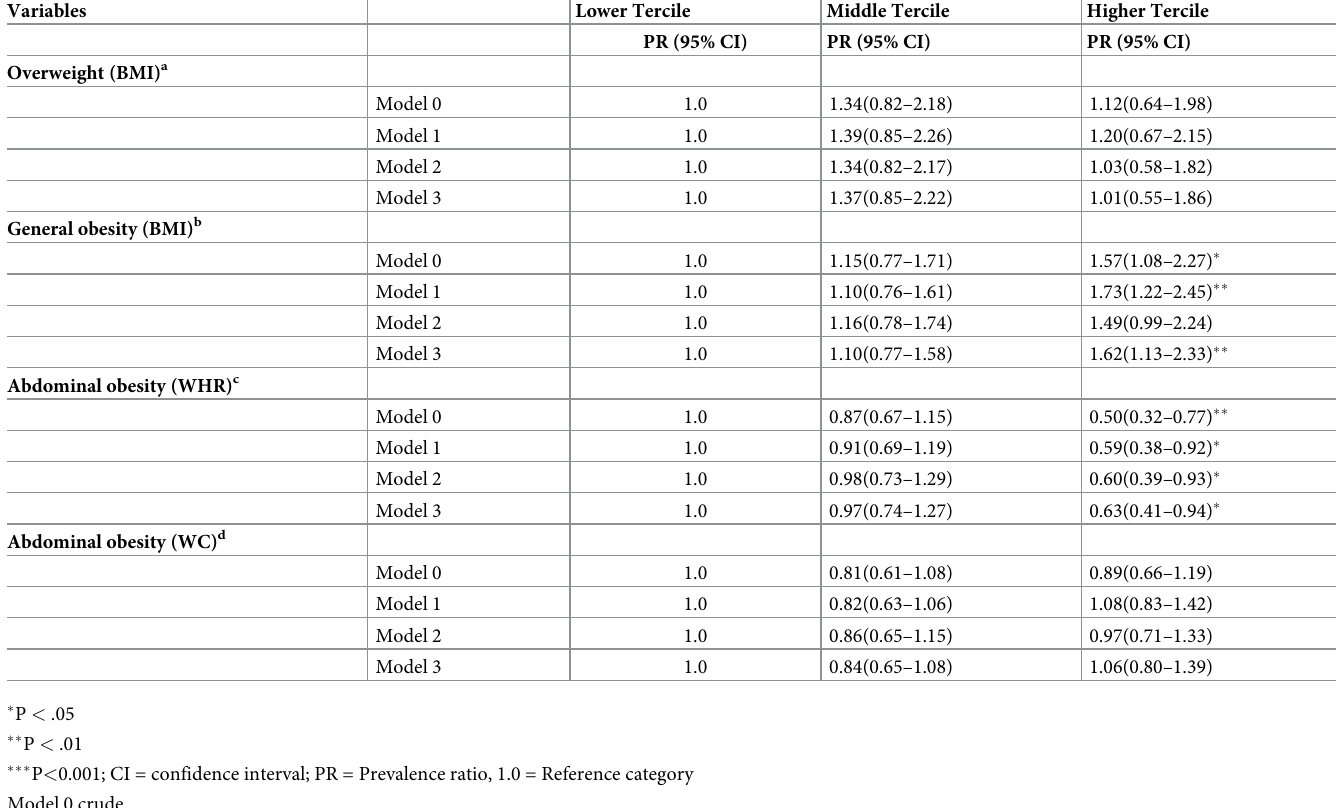
Table 4. Multivariate Poisson regressions (PR-Prevalence ratio and 95% confidence intervals) for dietary diversity (DDS Terciles) with overweight and obesity among female participants in Monduli district, Tanzania ( N =